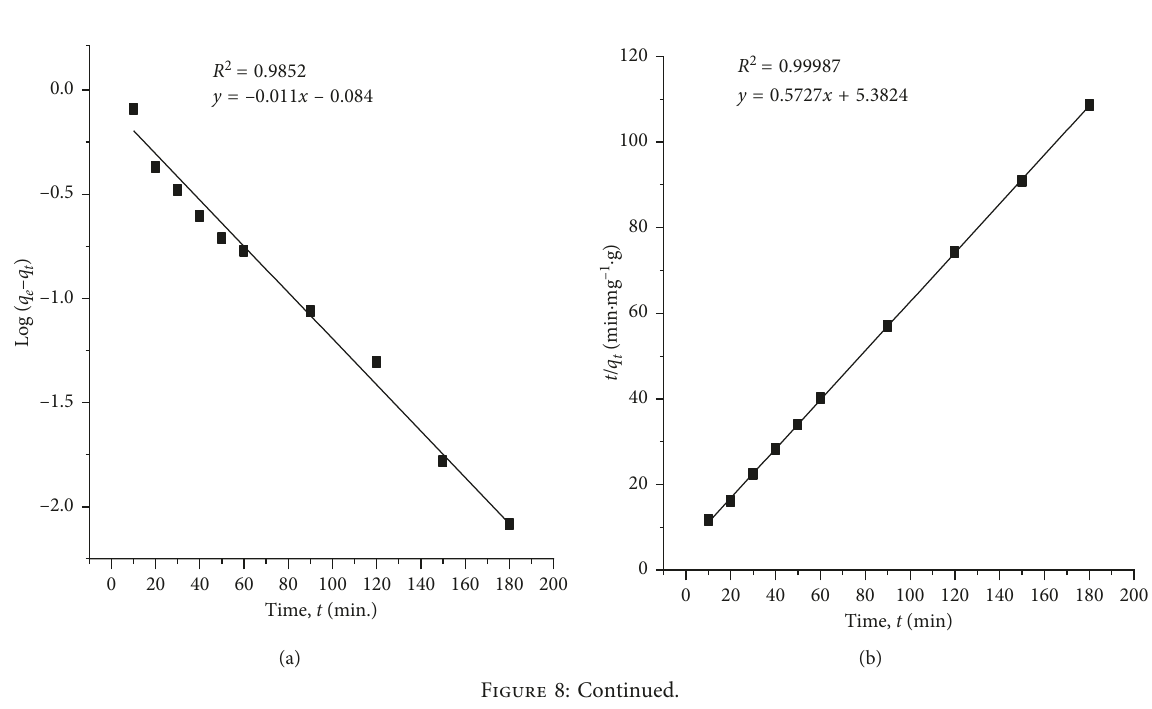
Figure 7: Effect of initial dye concentration on equilibrium ( q